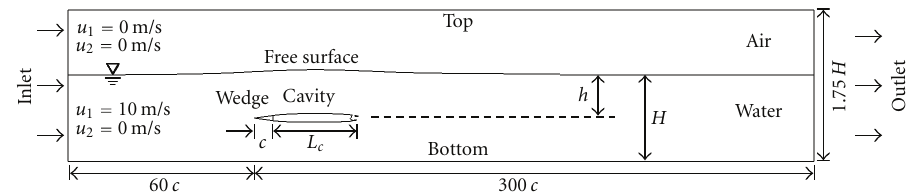
Figure 1: Computational domain and boundary specification.